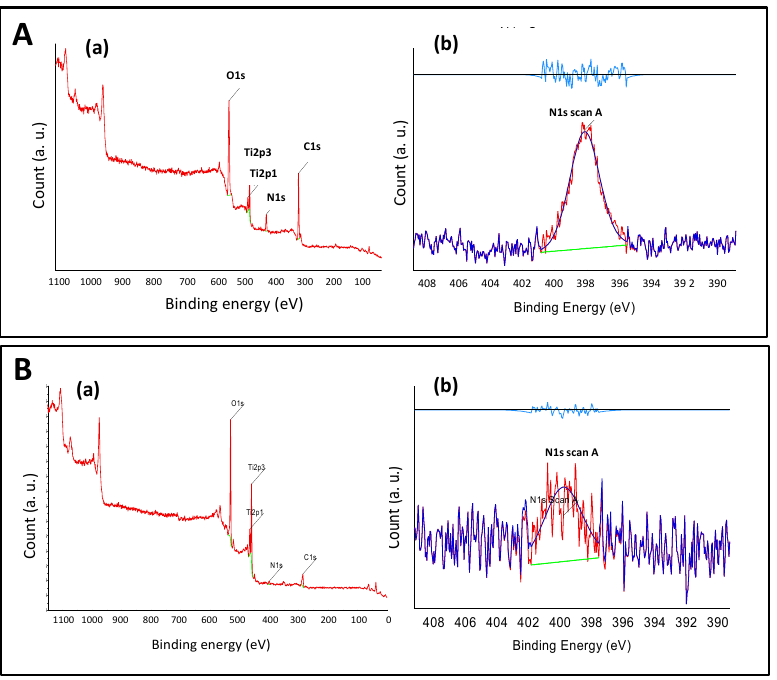
Figure 6. XPS spectra of ( A ) amorphous N/TiO 2 and ( B ) anatase N/TiO 2 ; ( a ) full scan, ( b ) N1s scan.